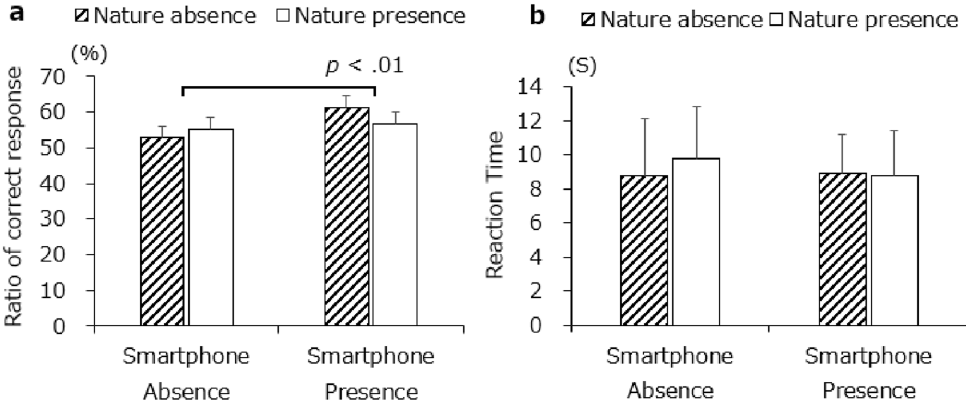
Figure 3. Ratios of ( a ). correct RAT response and ( b ). reaction time. Error bars depict standard error